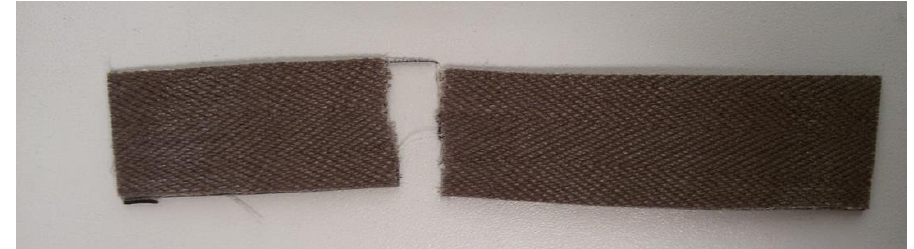
Figure 13. KKA-20-20 sample after tensile strength testing.